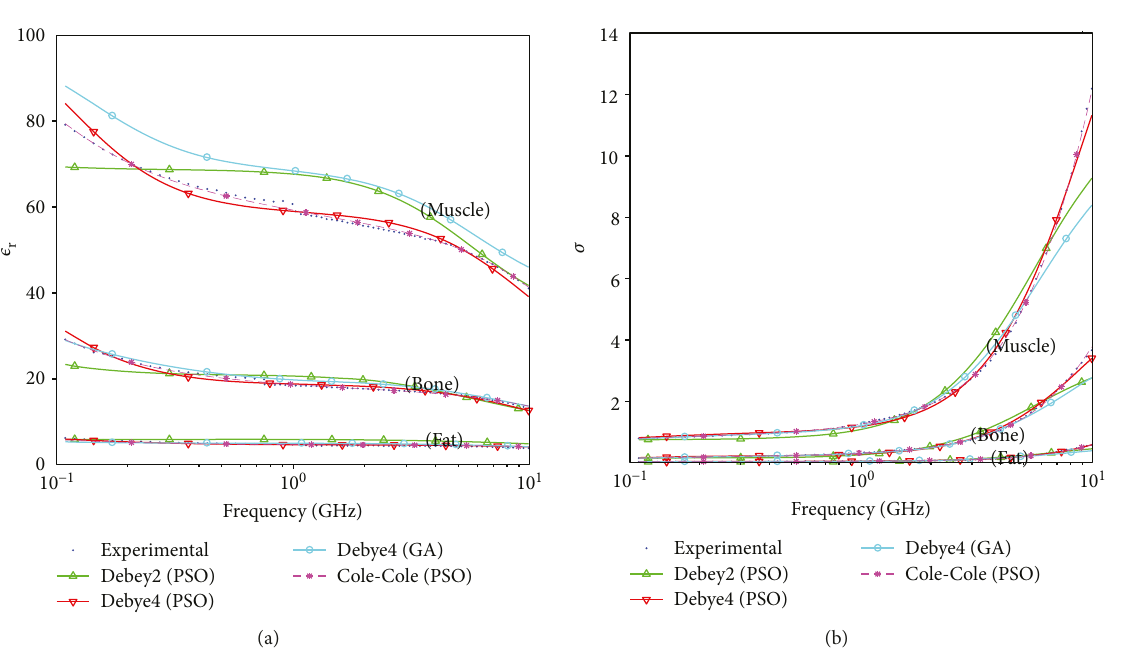
Figure 1: Properties of human body tissues using Debye model compared with the experimental data. (a) Relative permittivity. (b)